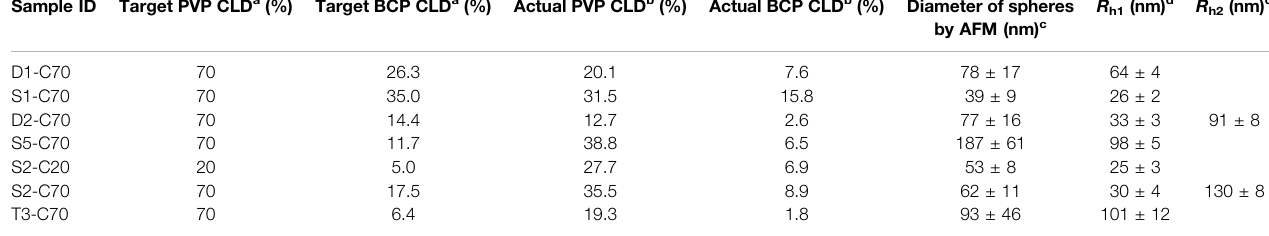
TABLE 2 | Properties of crosslinked PS – PVP BCP NPs.